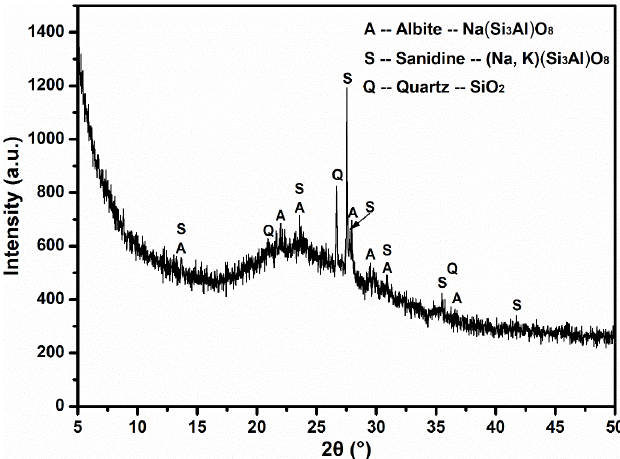
Figure 1. ESEM photomicrographs of the employed pumice stone.